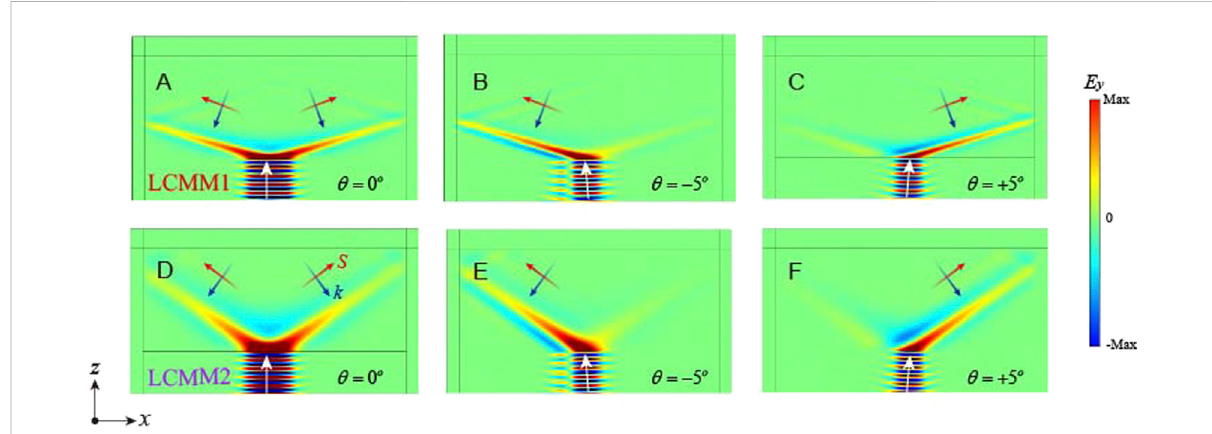
FIGURE 3 BeamsplittingandunidirectionalrefractionofMLCMMbasedontheDrude-Lorenzmodel. (A) Beamsplittingwhenthelightisnormallyincident on the LCMM1. (B), (C) The directional refraction of LCMM1 when the incident angle is − 5 o and + 5 o , respectively. (D – F) Similar to (A – C) , but for the LCMM2. The incident Gaussian beam is marked by the white arrows.